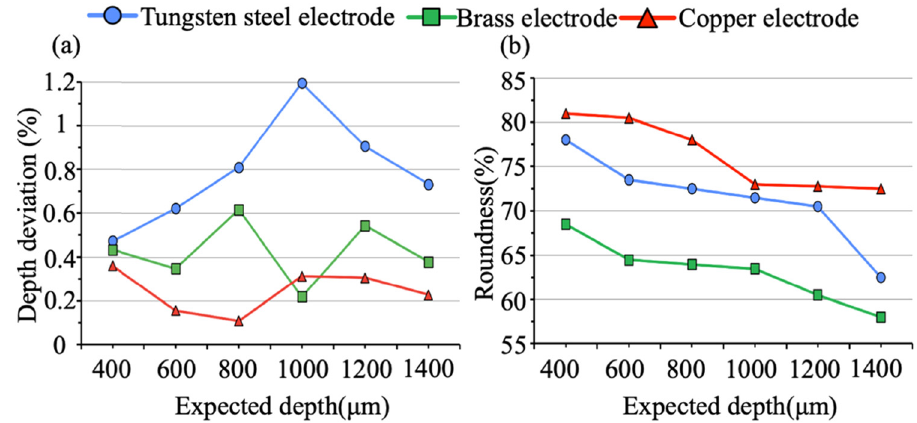
Figure 14: The precision of blind holes by di ff erent electrode materials: ( a ) the depth deviation; ( b ) the roundness factor ( frequency = 130 kHz, pulse width = 5 µs, current = 4.5, voltage = 90 V, gain coe ffi cient = 30 )